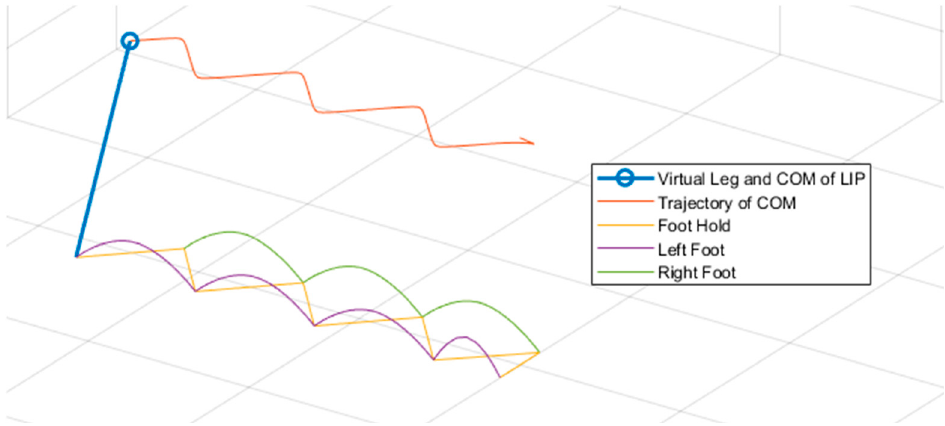
Figure 8. Generated trajectories of the center of mass and the position of the ZMP. In the second stage, the foot trajectory was generated based on the mutual position of the ZMP and the movement of the center of gravity. Trajectories were generated for eight cycle runs. The analysis showed that during the first two runs of the cycle, stride length and movement were less similar than during the rest of the runs. This phenomenon can also be observed in the first two steps of the model, when the feet in the initial position are located at a spacing of 91 mm from the robot axis, given by the construction. The model reaches the predetermined step width of 144 mm and length of 20 mm only during the third run of the cycle. The trajectories were stored in the data-structure footinfos 1 × 8 (Figure 9), where the column number determined the number of cycle run. One data element contained a 1 × 200 vector ( timevec ) with time values sampled for a one-second period. Furthermore, this element also contained the joint positions in space stored in two 6 × 200 matrices for the left leg ( footleft ) and the right leg ( footright ). The joints positions are represented by the amount of each joint rotation with respect to the defined direction using DH parameterization.